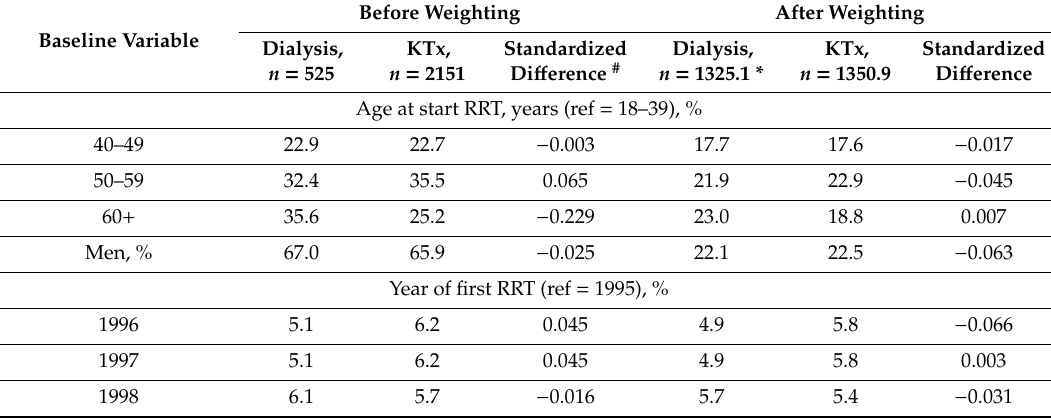
Table 1. Baseline characteristics before and after weighting in the dialysis and kidney transplantation groups for the patients on the waitlist ( n =